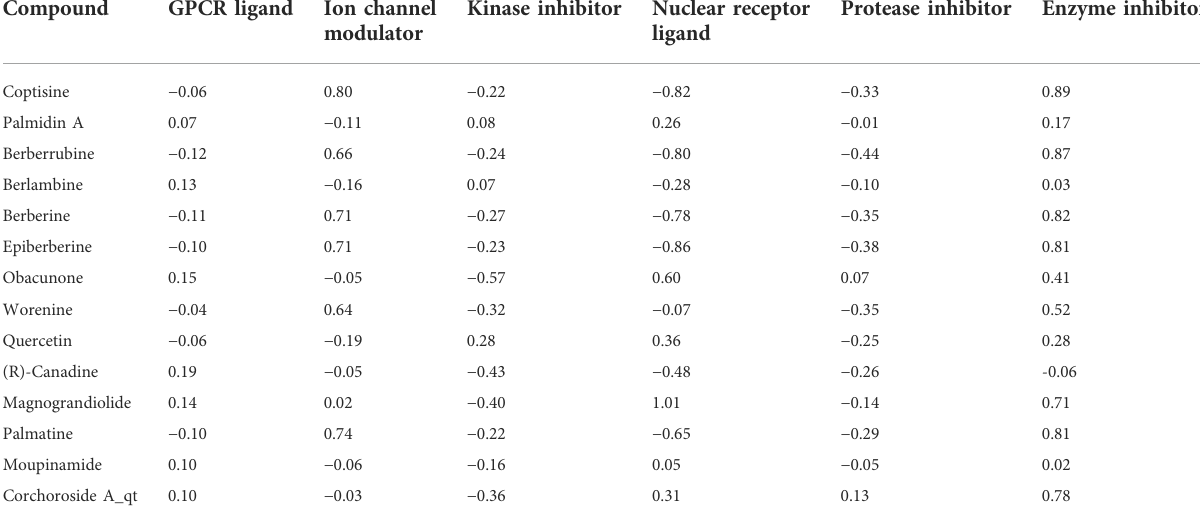
TABLE 3 Bioactivity scores of key phytochemicals of CR.